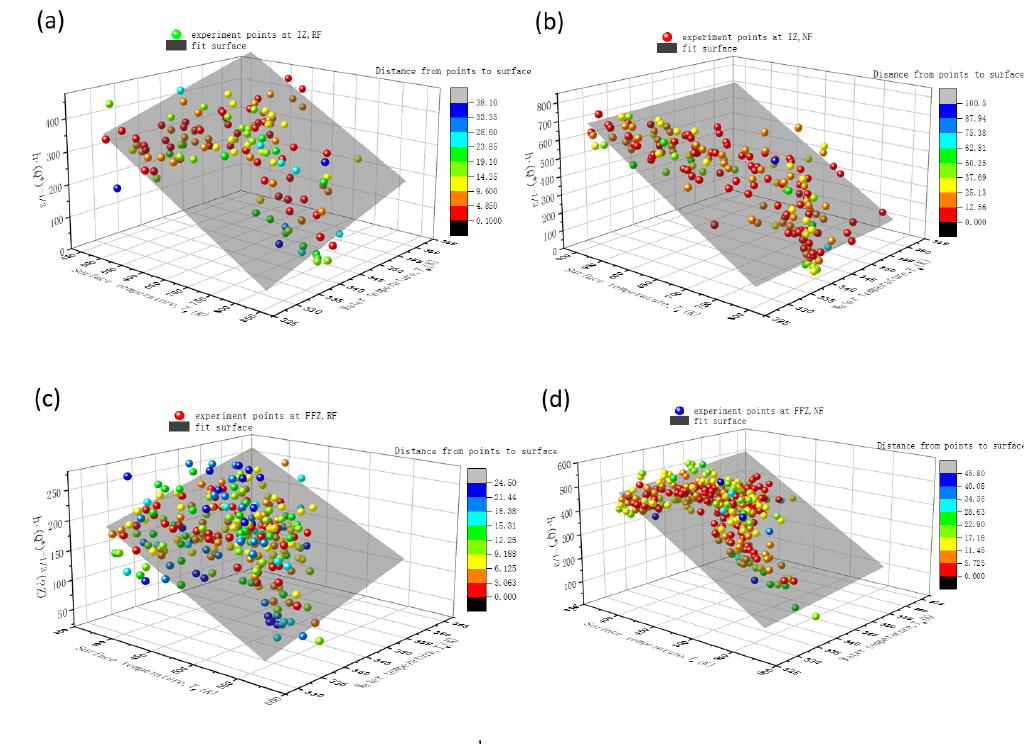
Figure 12. Comparison of h values conducted by DC casting temperature-measurement test and ( Q ∗ ) 1/3 surface fitted by Equations (20)–(23): ( a ) impingement zone ( IZ ) at rolling face ( RF ); ( b ) impingement zone ( IZ ) at narrow face ( NF ); ( c ) free-falling zone ( FFZ ) at rolling face ( RF ); ( d ) free-falling zone ( FFZ ) at narrow face ( NF ).